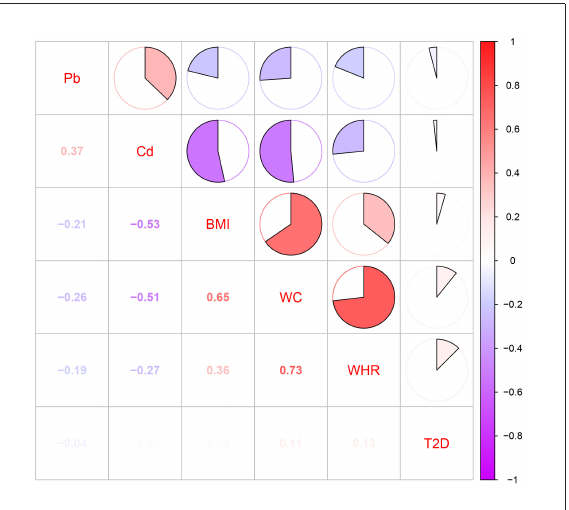
FIGURE2 The geographical location of sampling sites. A: Shishan B: Sitang C: Xiangyang D: Santang E: Shangcun F: Hongqi G: Kuixin H: Xinwuzai I: Kuifeng J: Nanao K: Diefu L: Pengcheng M: Futang N: Huangqitang O: